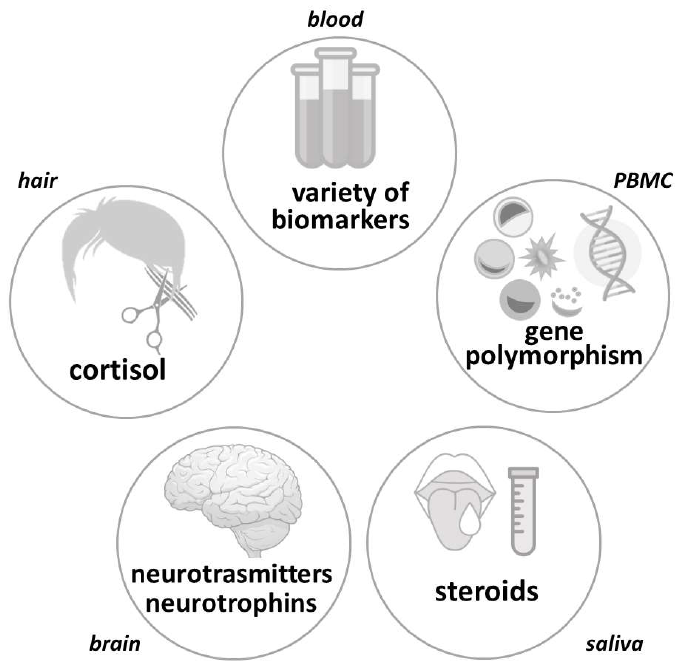
Figure 1. Different biomarkers related to stress, measured in select tissues and biological fluids in humans and experimental animals. PBMC—peripheral blood mononuclear cells.